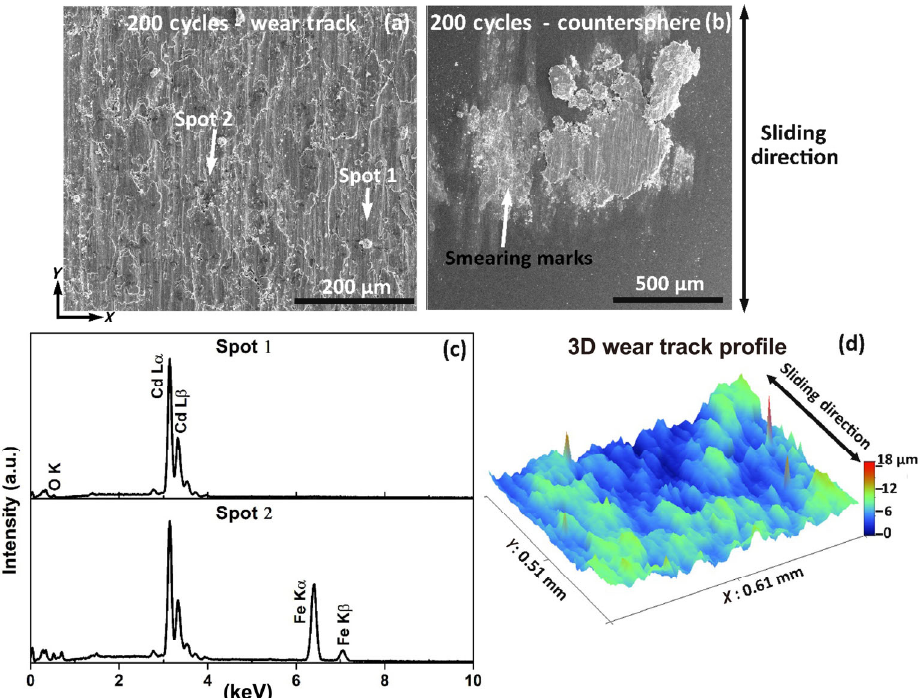
Fig. 4 (a) Wear track morphology indicating smeared Cd layer, (b) adhesive wear features on countersphere, (c) EDS analysis of wear track indicating presence of Cd and Fe substrate, and (d) three-dimensional (3D) profile of wear track at 200 cycles.